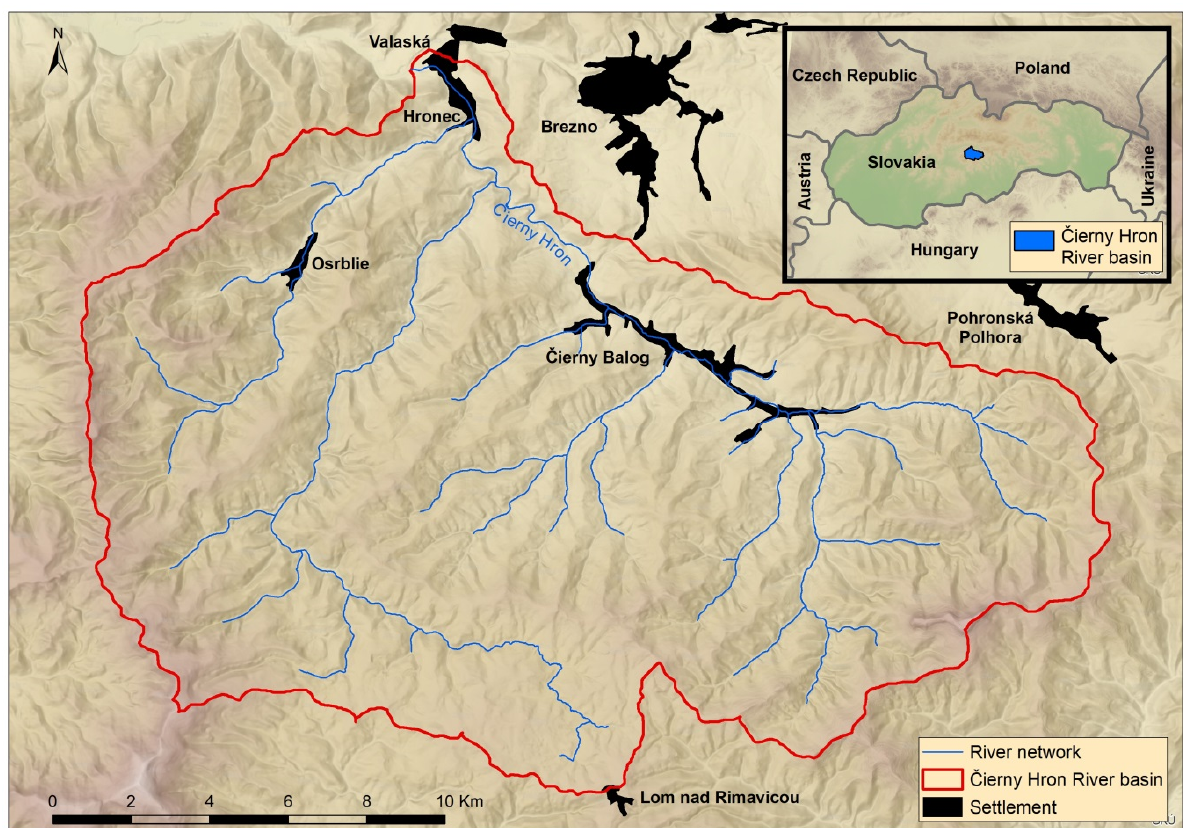
Figure 1. Study area.